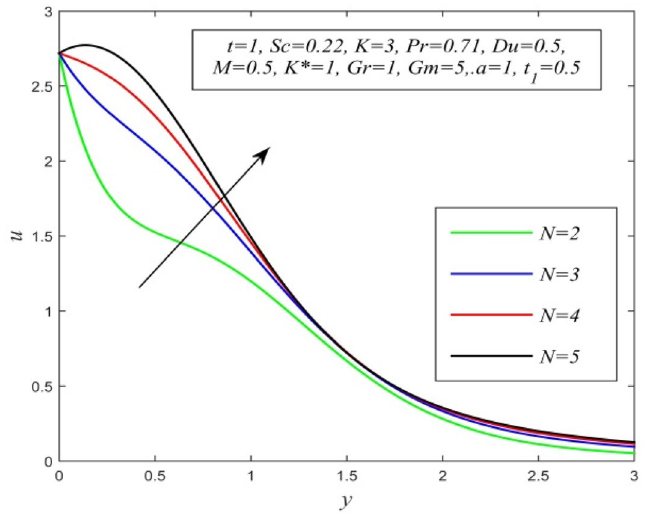
Figure 19. u versus y for different N and t = 1, Sc = 0.22, K = 3, Pr = 0.71, Du = 0.5, M = 0.5, K* = 1, Gr = 1, Gm = 5, a = 1, t 1 = 0.5.